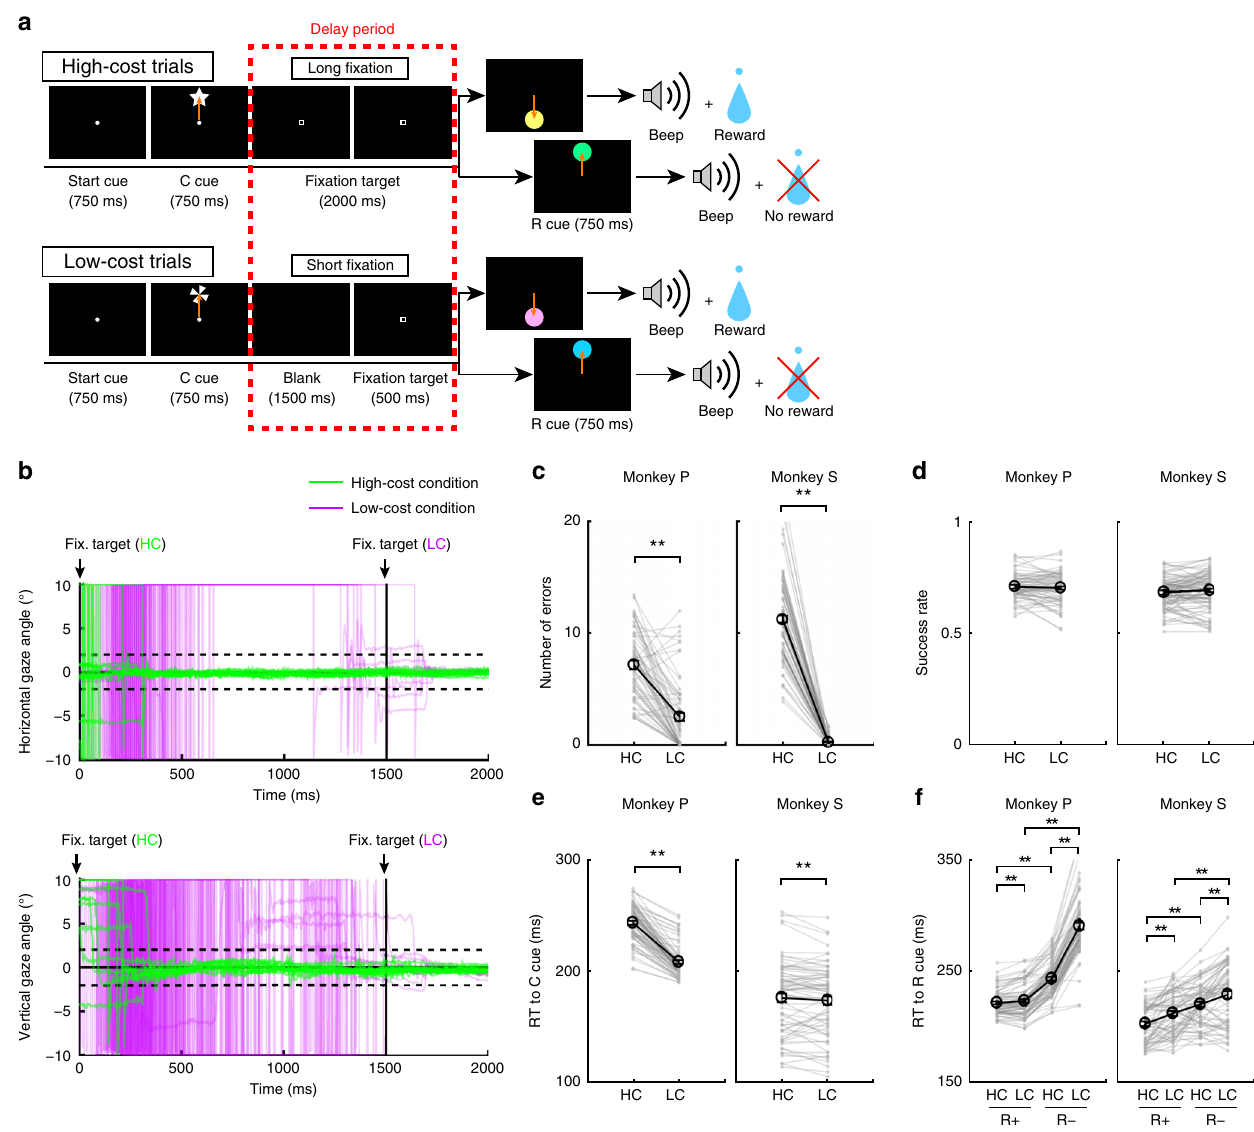
Fig. 1 HLC saccade task. a The HLC saccade task. Cost cues (C cue) signaled the amount of effort that was required to achieve a potential reward. A long fi xation was required during the delay period in high-cost trials. The reward cue (R cue) indicates whether the monkeys could obtain a reward or not. b The time course of the gaze angle during the delay period. The upper and lower panels show the horizontal and vertical gaze angles, respectively. Green and purple lines indicate the gaze angle in high-cost trials (50 trials in each panel) and in low-cost trials (50 trials in each panel), respectively. c The number of errors during the delay period in the high-cost and low-cost trials (** P < 0.01; two-tailed paired t test; t 67 = 8.8, P = 4.8 × 10 − 15 , n = 68 for Monkey P; t 83 = 26.6, P ≈ 0, n = 84 for Monkey S). Black circles and error bars indicate mean and SEM. d Success rates in the high-cost and the low-cost trials (two-tailed paired t test; t 67 = 0.51, P = 0.61, n = 68 for Monkey P; t 83 = 0.79, P = 0.43, n = 84 for Monkey S). e RTs to the cost cues (** P < 0.01; two-tailed paired t test; t = 20.4, P ≈ 0, n = 68 for Monkey P; t = 2.0, P = 1.2 × 10 − 3 , n = 70 for Monkey S). f RTs to the reward cues (** P < 0.01; two-tailed paired t test; 67 69 Monkey P ( n = 68): HC + vs. LC + , t 67 = 3.5, P = 9.2 × 10 − 4 ; HC − vs. LC − , t 67 = 24.5, P ≈ 0; HC + vs. HC − , t 67 = 21.6, P ≈ 0; LC + vs. LC − , t 67 = 28.5, P